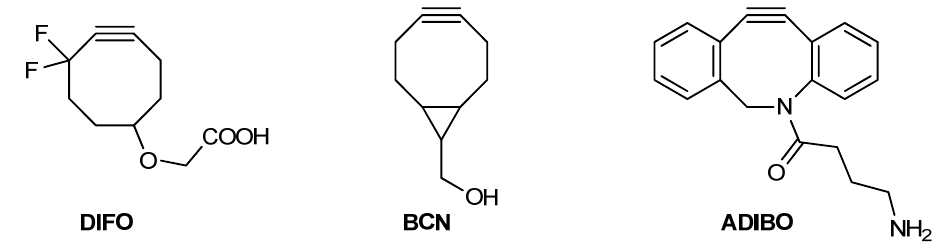
Figure 1. Difluorinated cyclooctyne (DIFO)-, bicyclo[6.1.0]nonyne (BCN)- and azadibenzocyclooctyne (ADIBO)-type SPAAC